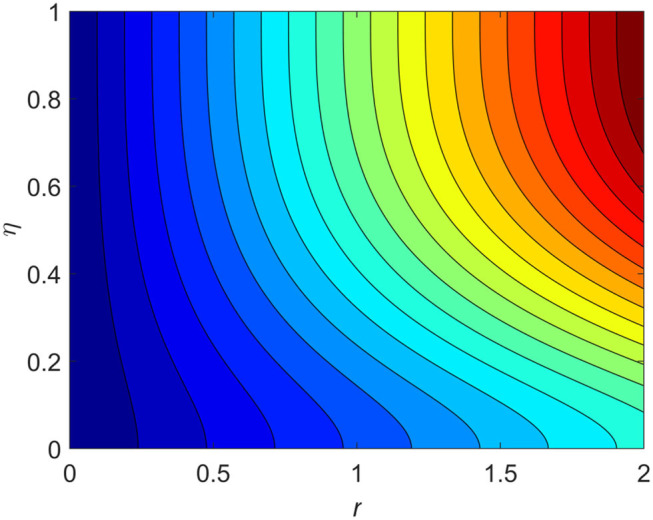
Streamline patterns for suction A = 0.2 > 0.